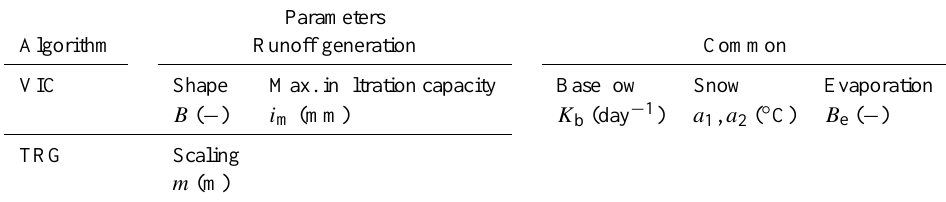
Table 1. Model parameters for the common model framework used to evaluate the VIC and TRG runoff-generation algorithms.